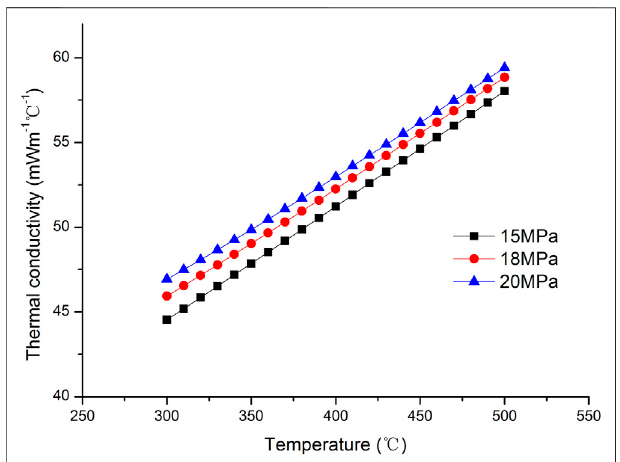
FIGURE 7 | The thermal conductivity of CO 2 varies with pressure and